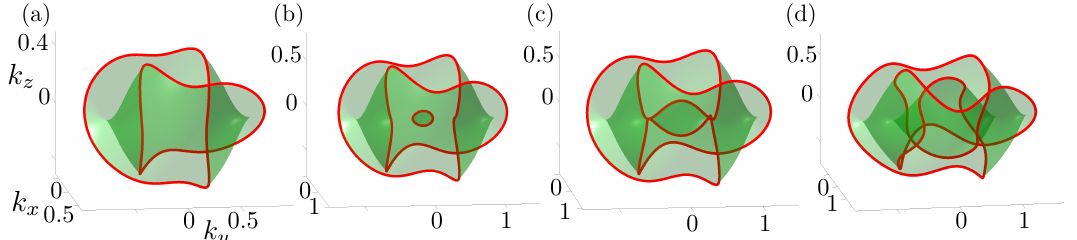
Figure 3: Illustration of how the transitions in a lattice model defined by Eq. (8), Eq. (12) and Eq. (17) take place when n = 2 with Λ = 100. In (a) ε = 0.1 which results in a ( 2,2 ) torus link, the Hopf link. Eventually, a new circle appears in the center, which is illustrated in (b) for ε = 0.26. This circle merges with the Hopf link when ε is allowed to grow, and the critical value ε = 0.303 is displayed in (c). For larger ε , the figure-eight knot, or more generally, the ( 3, n ) Turk’s head knot is obtained, displayed in (d) for ε =